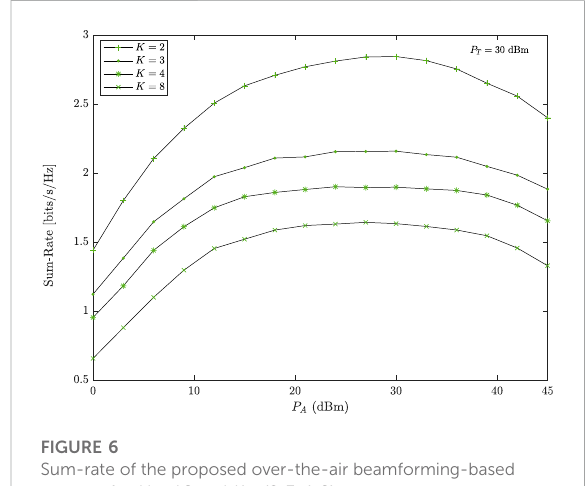
FIGURE 6 Sum-rate of the proposed over-the-air beamforming-based systems for N = 16 and K ∈ 2 , 3 , 4 , 8 { } .